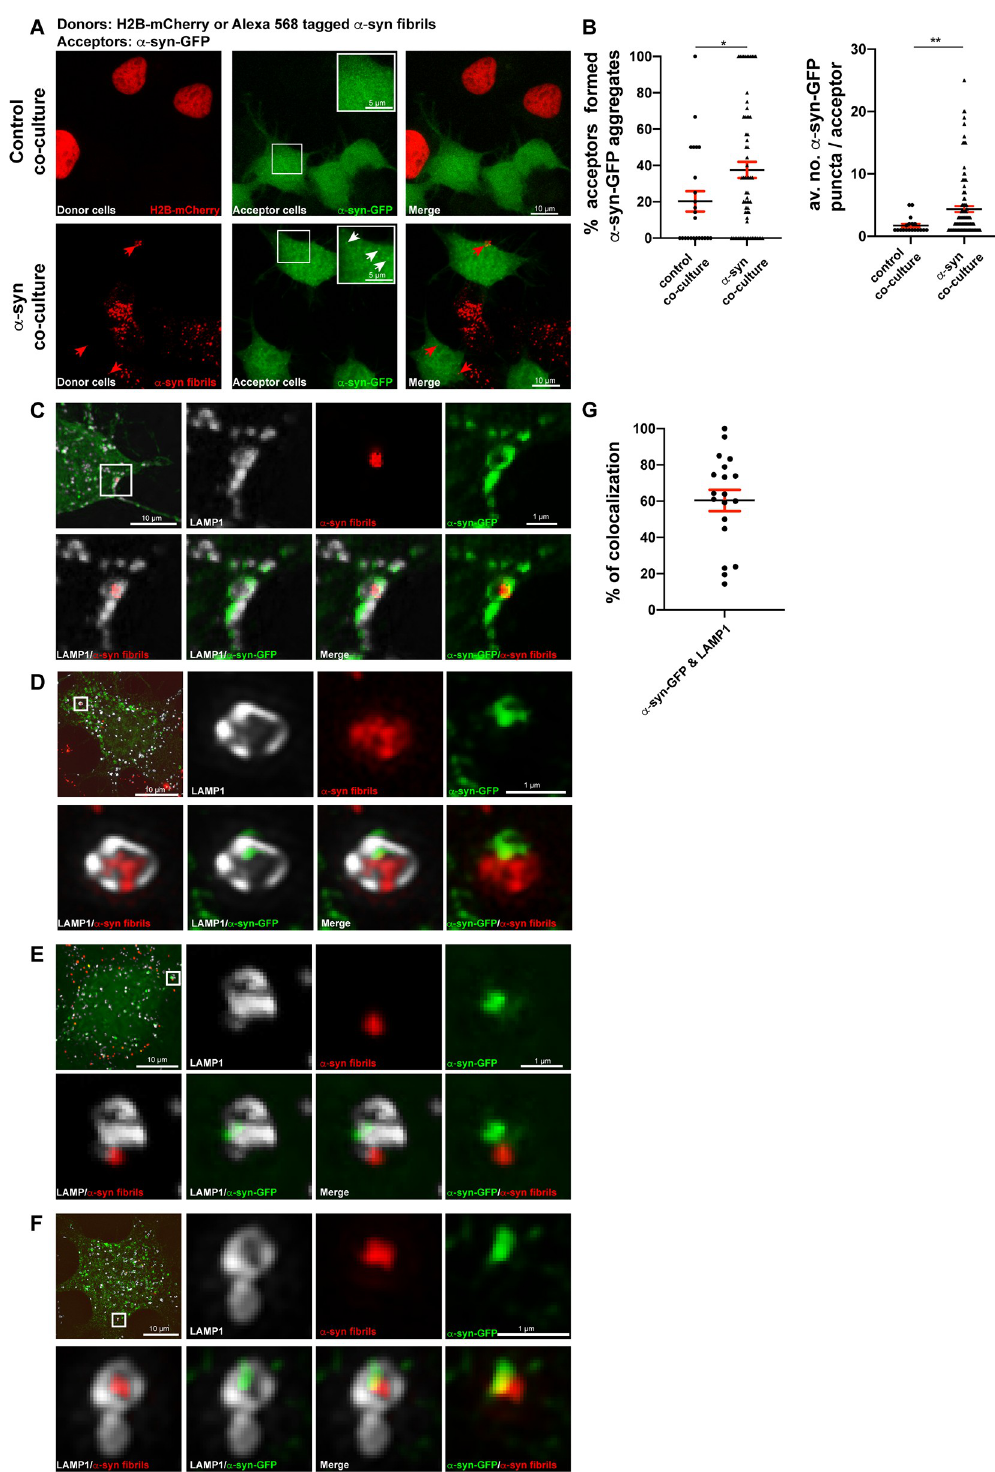
Fig 9. α -syn fibrils induce seeding after their transfer into acceptor cells, and this event is frequently associated with lysosomes. (A) Representative confocal images of donor and acceptor cells after 24 hours of coculture. Donor cells were transfected with H2B-mCherry (control coculture) or treated with Alexa 568–tagged α -syn fibrils for 18 hours ( α -syn coculture). Acceptor cells were transfected with α -syn-GFP. Inset of acceptor cells (indicated by white squares) is presented at the right top corner of acceptor cells’ panel. White arrows indicate α -syn-GFP aggregate formation, and red